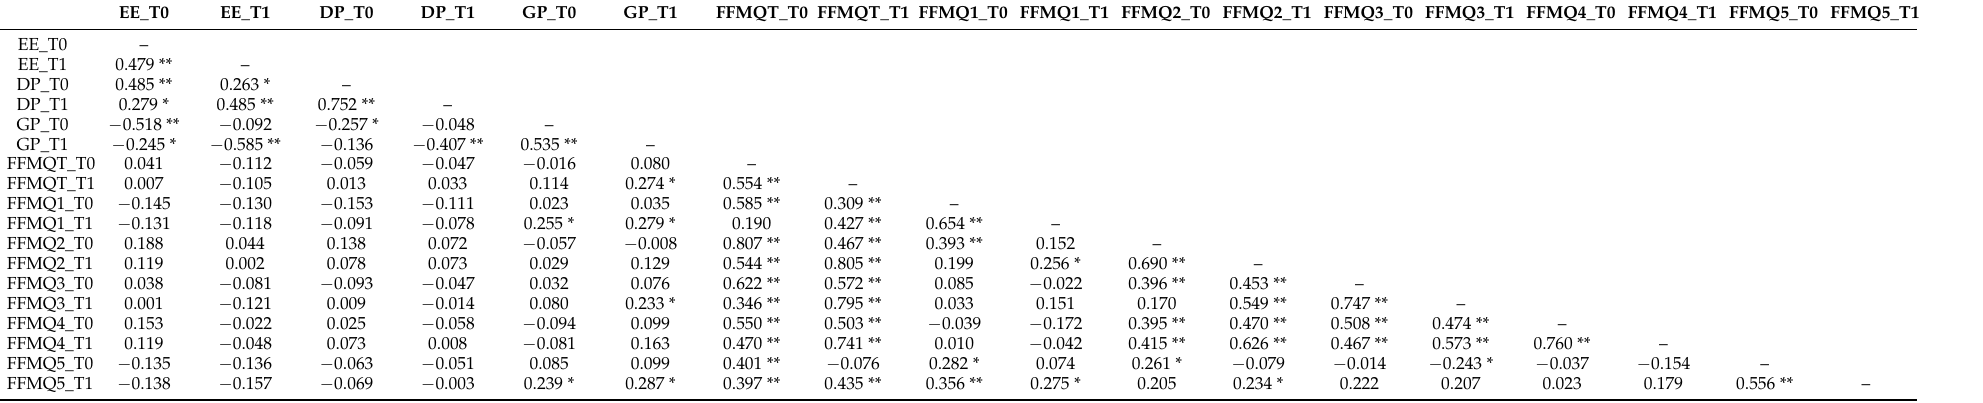
Table A2. Association between Maslach Burnout Inventory and Five Facet Mindfulness